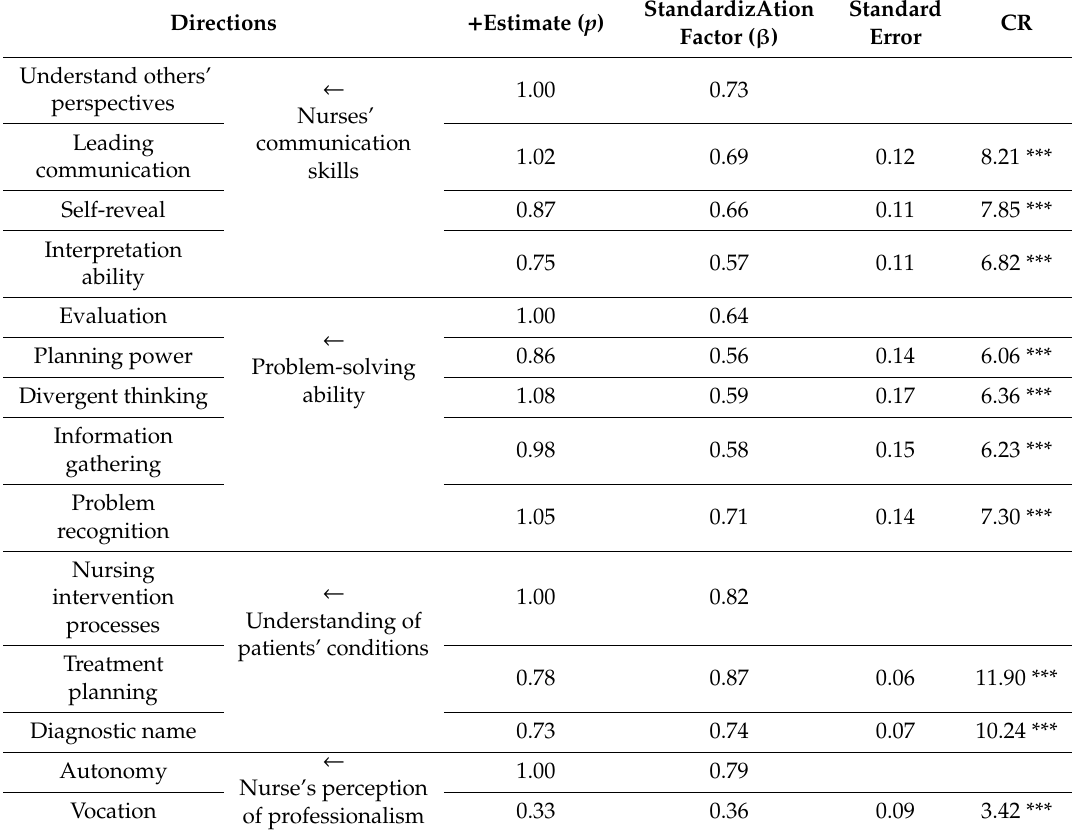
Table 4. Confirmatory factor analysis of the measurement